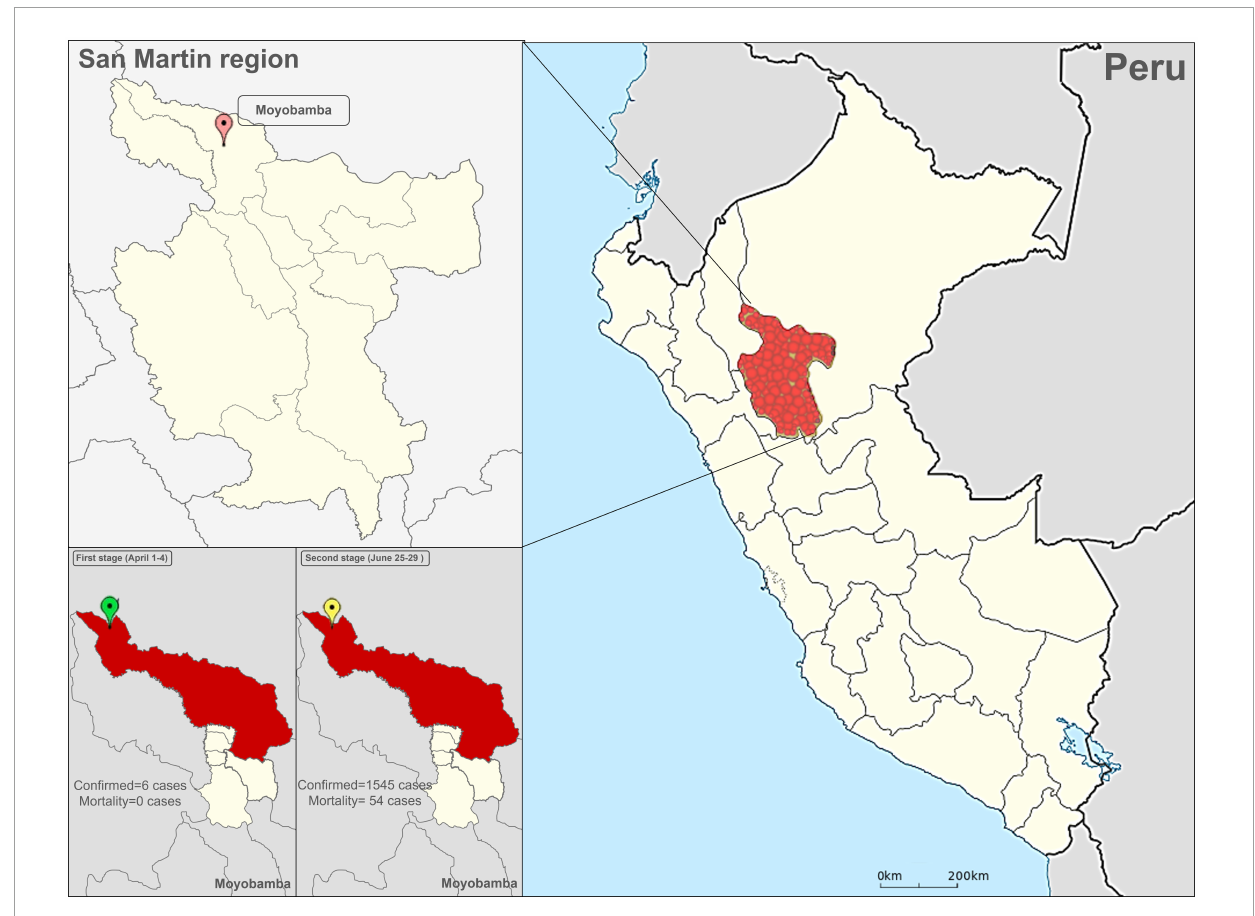
FIGURE1 Location of the San Martin region in the Peruvian jungle. The confirmed cases and deaths from COVID-19 in the two stages of the study are shown in the lower